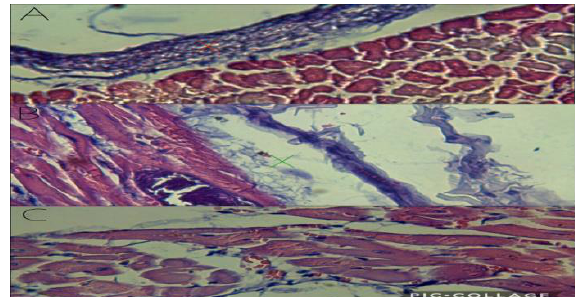
Figure 15. Distal subepicardial section. A, showing transverse running pattern of muscle fibers near the endocardium (red x). B, showing longitudinal running pattern of muscle fibers near the epicardium (green x). C, showing mixed running pattern of muscle fibers in the center of the subepicardial